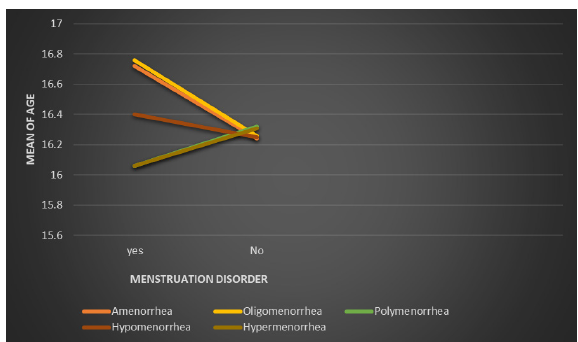
Figure 1. Relationship Between Age and the Presence or Absence of Menstrual Disorders.